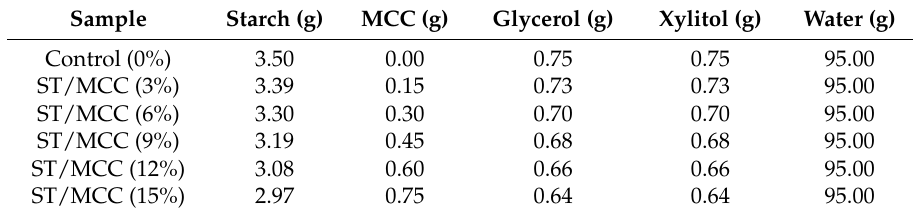
Table 1. The proportion of the formulations of ST/MCC samples